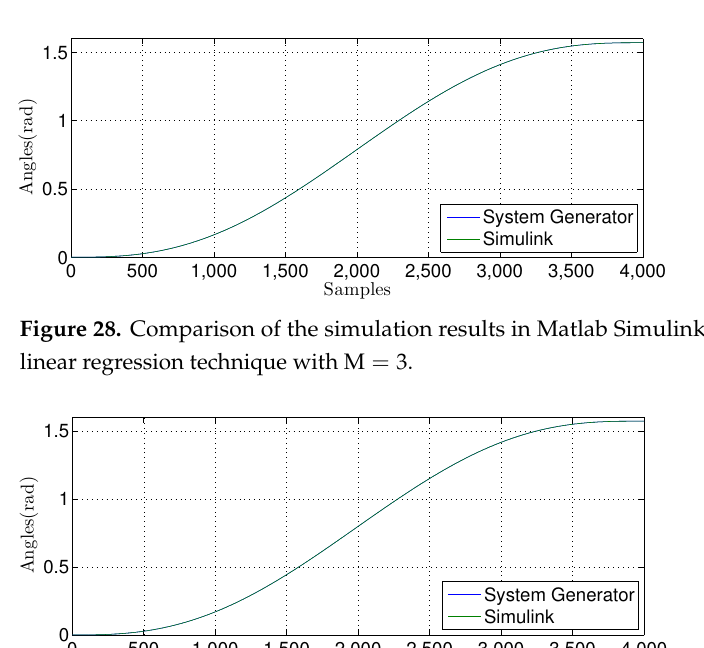
Figure 27. Comparison of the simulation results in Matlab Simulink and system generator for the linear regression technique with M = 1.